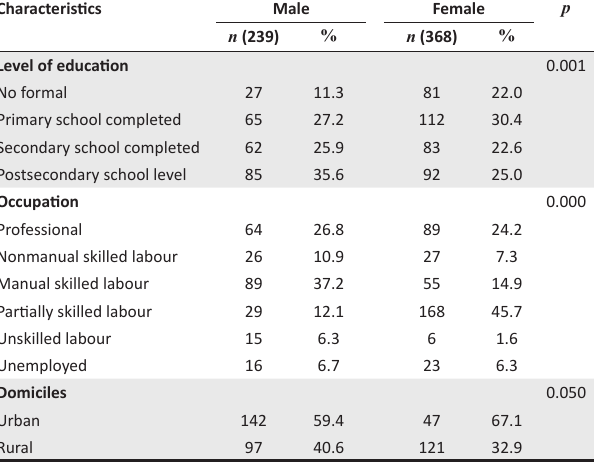
TABLE 1: Distribution of educational status, occupations and place of domicile. Characteristics